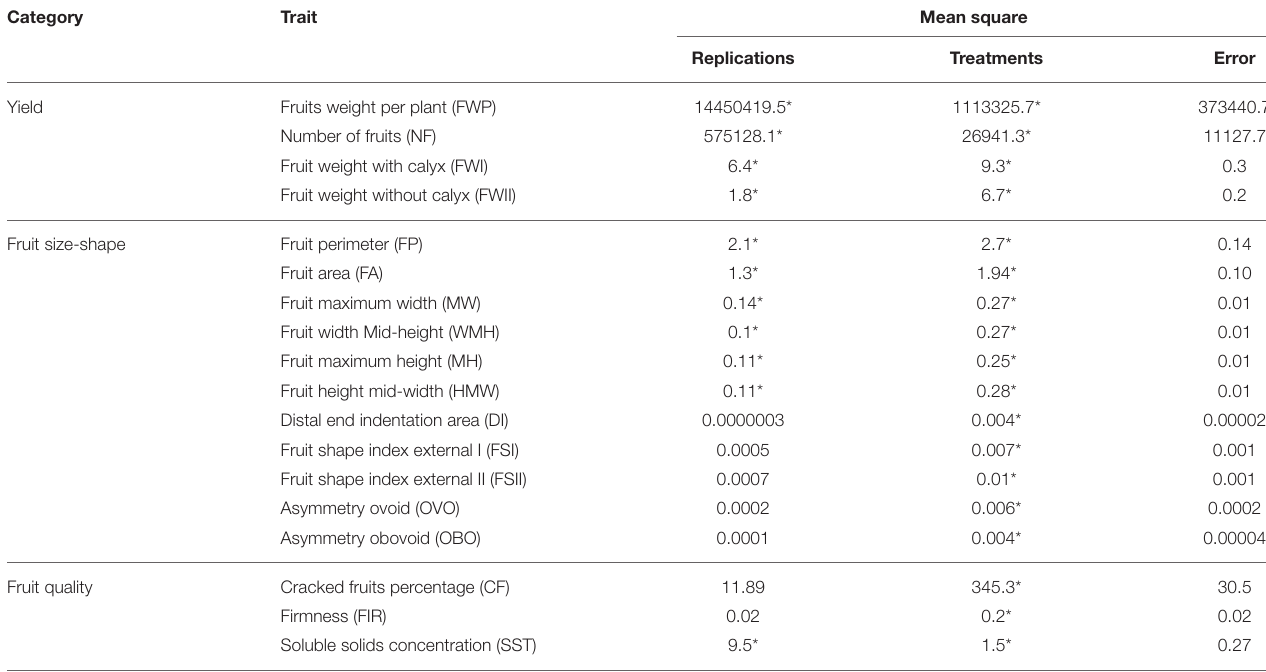
TABLE 1 | Analysis of variance for 18 traits of cape gooseberry accessions.